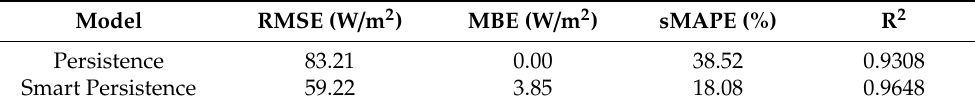
Table 6. Comparison of persistence and smart persistence models based on test data.